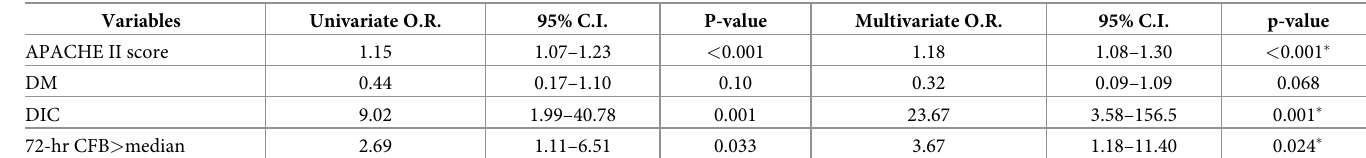
Table 2. Univariate and multivariate analysis of risk factors associated with MODS in patients with septic shock. Variables Univariate O.R.